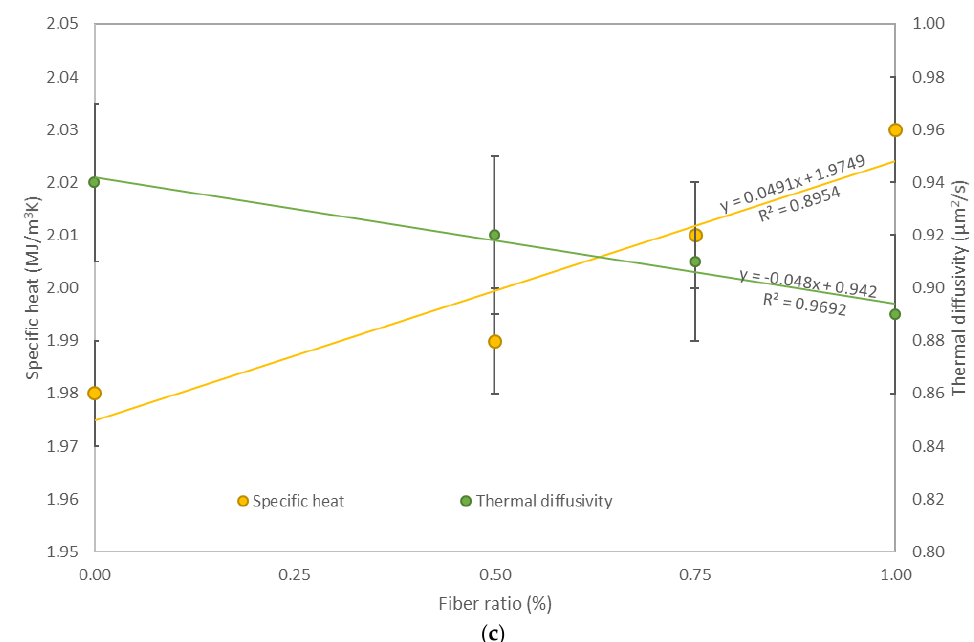
Figure 7. Specific heat and thermal diffusivity test results: ( a ) glass fiber concretes; ( b ) polypropylene fiber concretes; ( c ) steel fiber concretes.